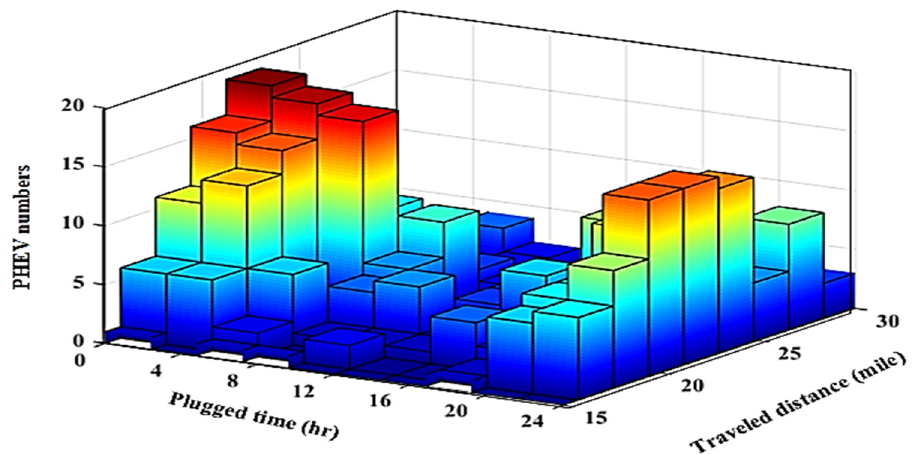
Figure 9. Distribution of plugged time and traveled distance for 400 EVs.